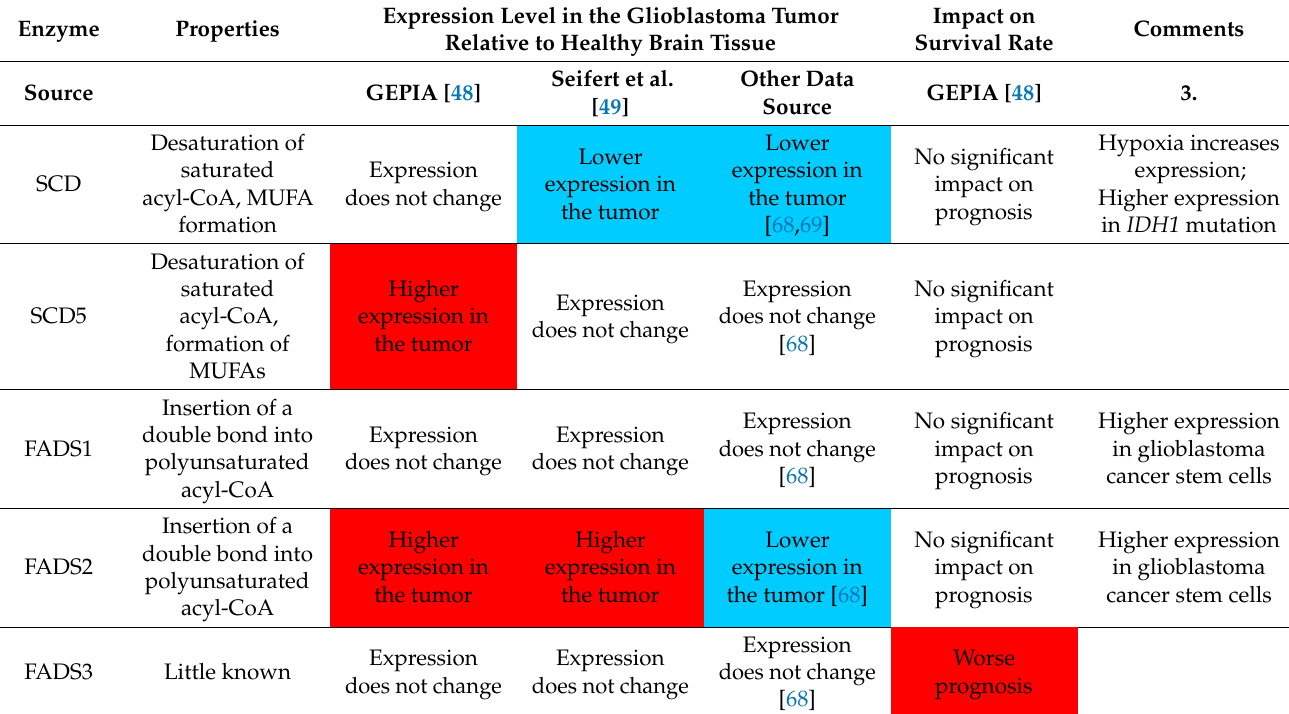
Table 3. Characteristics of desaturases involved in the biosynthesis of fatty